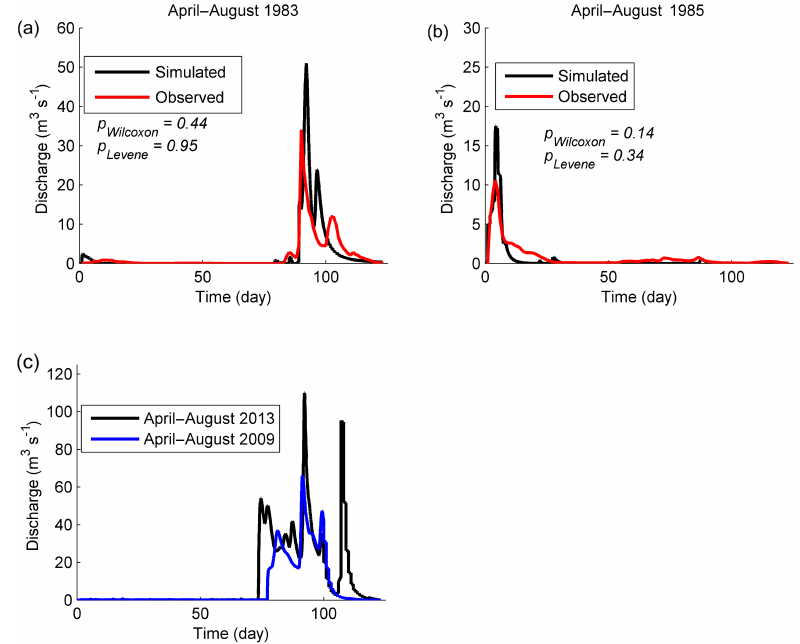
Figure 4. Simulated and observed stream flow at the Beaverhill Creek monitoring station. (a) Performance of the calibrated overland flow model in the simulation of stream flow against observed stream flow for the wettest period when the observed stream flow measurements were available from 1 April to 1 August 1983. The correlation coefficient between observed and simulated hydrographs was 87% ( p <0.001). (b) Performance of the overland flow model in the validation phase for the driest period when the observed stream flow measurements were available from 1 April to 1 August 1985. The correlation coefficient between observed and simulated hydrographs was 45% ( p <0.001). P Wilcoxon and P Levene refer to the P values of Wilcoxon and Levene tests used to assess the similarity in median and variance between two hydrographs. (c) Simulated hydrograph from 1 April to 1 August 2013 when the largest net surface water fluxes since 2000 occurred, and from 1 April to 1 August 2009 when the smallest net surface water fluxes since 2000